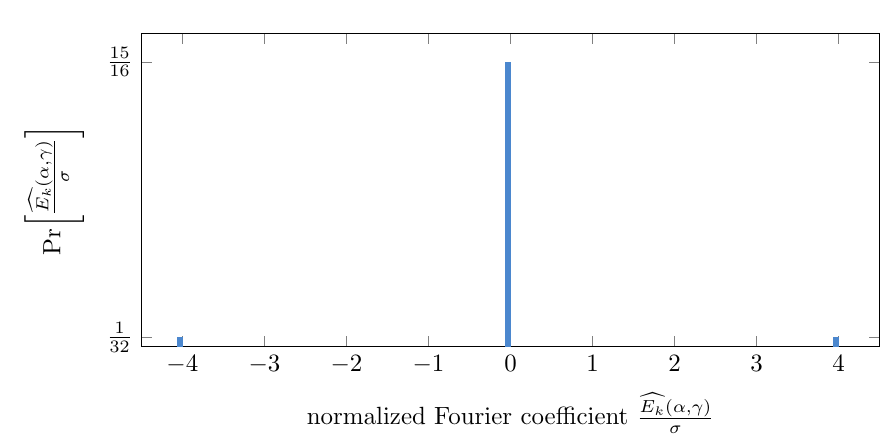
Figure 9: Convergence distribution for Present with R 1 S-box and many rounds. Here, the Fourier coefficient of ( e 63 , e 42 ) is normalized by the standard deviation σ (x-axis), while the corresponding probability to obtain such a Fourier coefficient is denoted on the